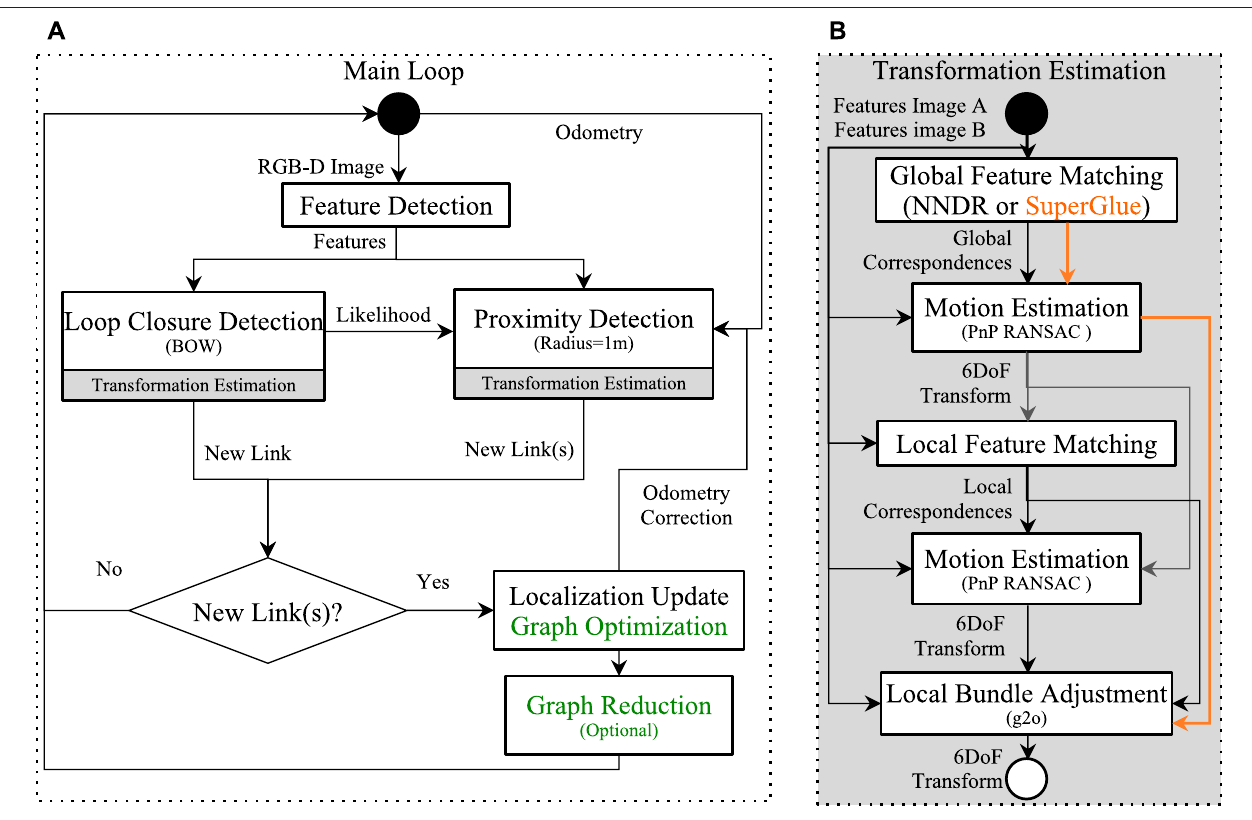
FIGURE2| MainloopoftheSLAMapproachused.Ingreenarestepsonlydoneduringmulti-sessionSLAMphasewhencombiningthemappingsessions.During localization phase, only Localization Update is done if new link (re-localization) has been added (the graph is not modi fi ed, only odometry correction is applied).